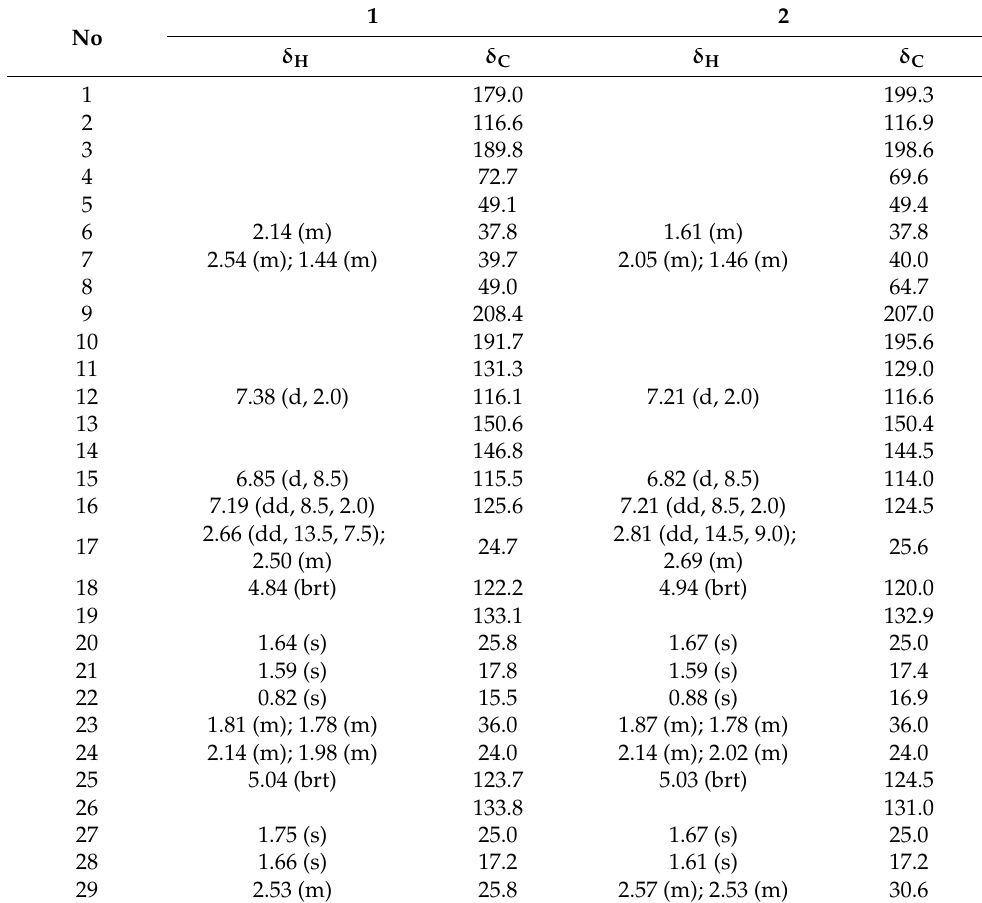
Table 1. 1 H (500 MHz) and 13 C (125 MHz) NMR data of compounds 1 and 2 (acetone- d 6 , δ , ppm,